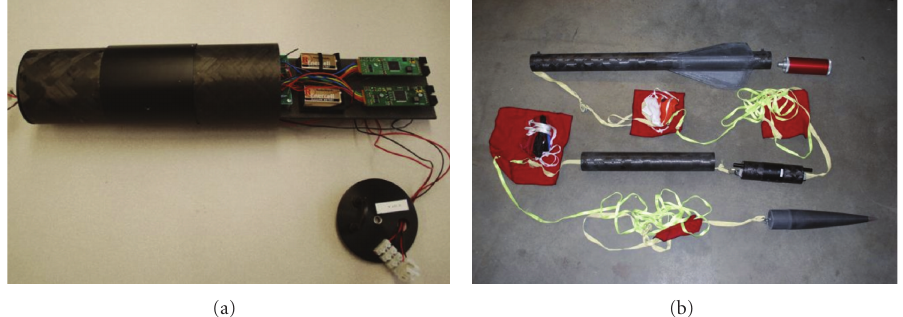
Figure 7: Images of the sounding rocket: (a) altimeter bay with RDAS units; (b) exploded view of Mongoose 98 Rocket. The entire length of the assembled rocket is about 8 feet 6 inches and the outside diameter is 4 (cid:4)(cid:4) .